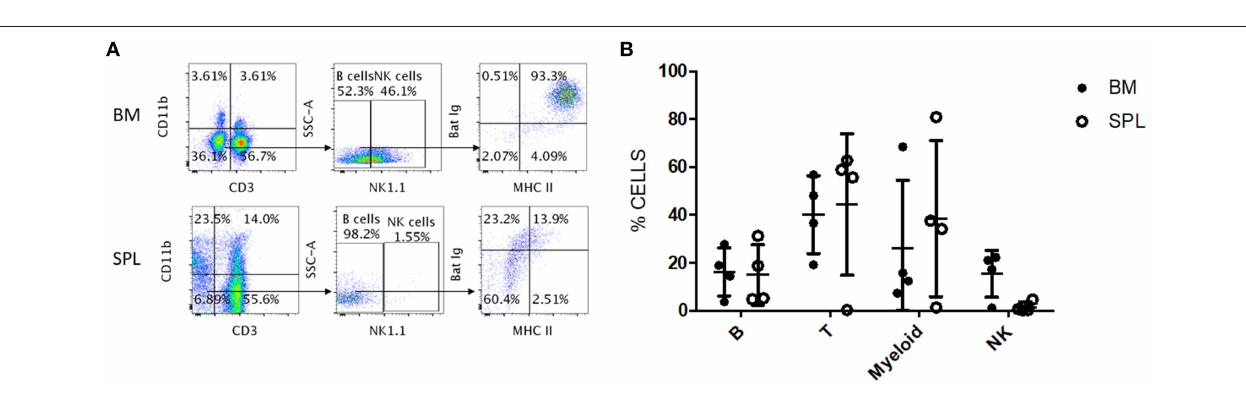
FIGURE 7 | Flow cytometry analysis of E. spelaea immune cells using cross-reactive antibodies. (A) E. spelaea immune cells from spleen and bone marrow were analyzed by flow cytometry. CD3 + CD11b − cells were identified as T cells and CD3 − CD11b + cells as myeloid cells. CD3 − CD11b − were further characterized based on NK1.1 to exclude NK cells and the CD3 − CD11b − NK1.1 − cells were identified as B cells. The B cell population was further identified by detection of MHC-II and sIg. Gates were set using FMO controls. (B) Individual percentages of B, T, myeloid and NK cell populations in the bone marrow and spleen of E. spelaea bats. Percentages of cells from 4 individual bats ( n =